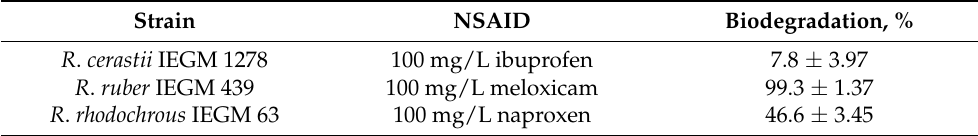
Table 1. Biodegradation of NSAIDs by rhodococci on the seventh day of the